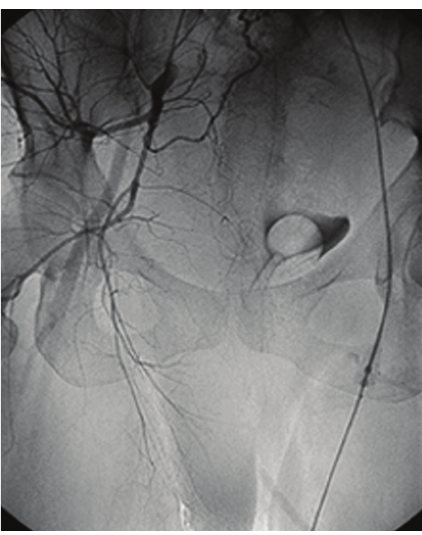
Figure 1: A mass effect from the vulvovaginal hematoma is noted, displacing the bladder laterally towards the left side. Selective angiographic embolization allows for the visualization of only the pertinent anatomy, obviating spatial coordination challenges associated with laparotomy in situs